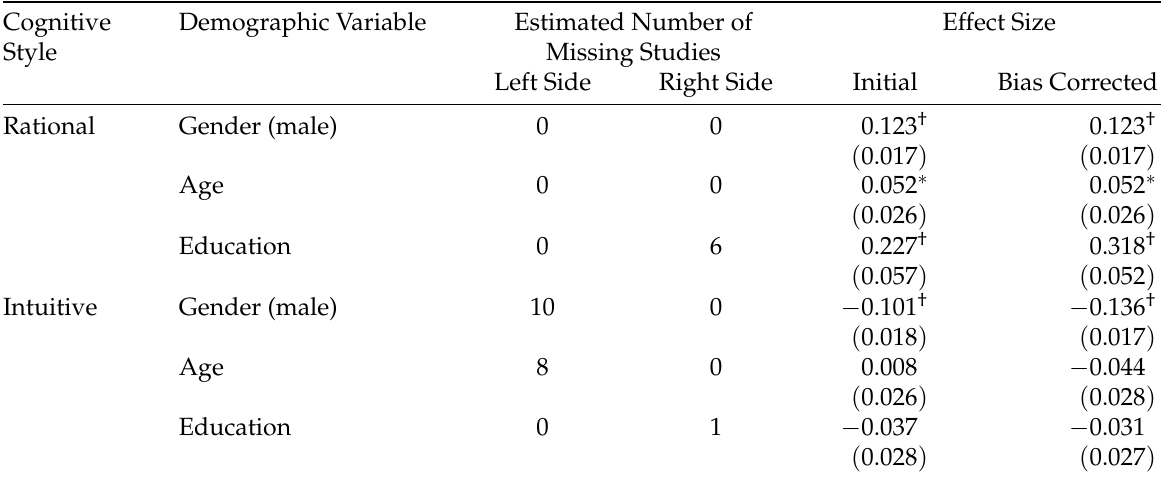
Table 2: Trim-and-Fill Estimates of Meta-Analytic Effects